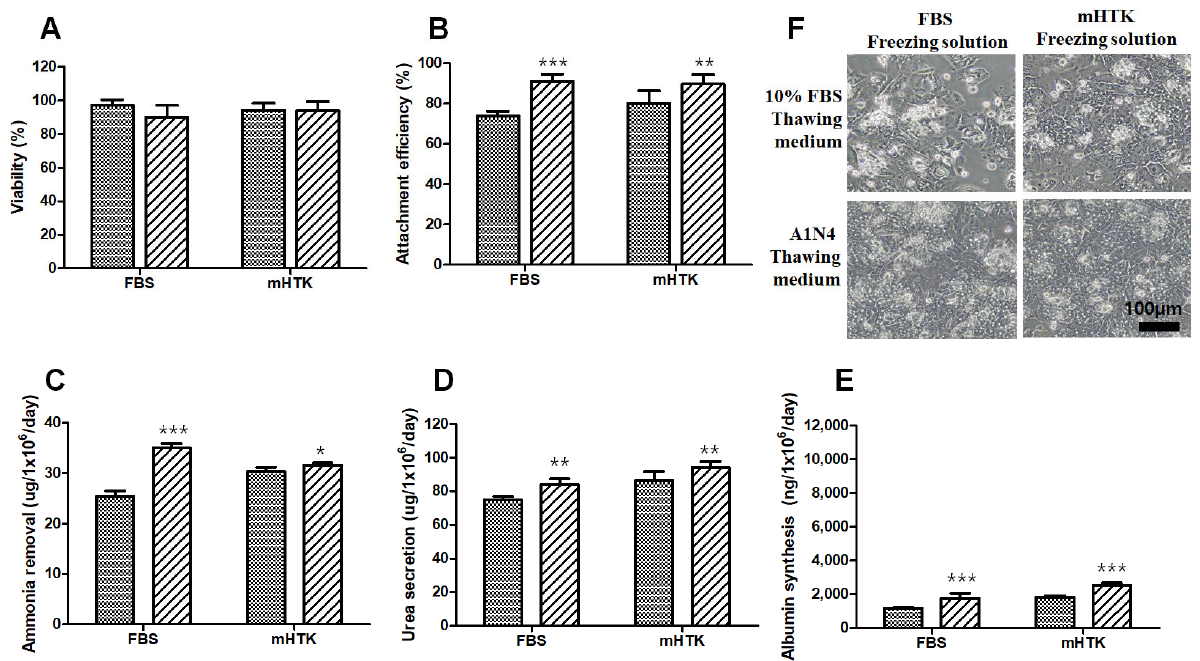
Figure 6. Effect of freezing and thawing solutions on porcine hepatocyte spheroids’ viability and liver-specific functions in post-thawing culture. Porcine hepatocyte spheroids were cryopreserved in two different freezing solutions supplemented with 15% DMSO and stored for 1 year in liquid nitrogen. Porcine hepatocyte spheroids were warmed rapidly using a water bath and washed twice in two different thawing solutions (a warm serum medium (10% FBS, ▩ ) or serum ‐ free medium )) and then resuspended in a warm complete medium and evaluated for ( A ) cell viability; ( B ) attachment efficiency using a (3-(4,5-dimethyl thiazol-2-yl)-2,5-diphenyltetrazolium bromide assay; ( C ) ammonia removal; ( D ) urea secretion; and ( E ) albumin synthesis after 24 h of culture. Representative images of ( F ) porcine hepatocyte spheroids showing their morphology after plating and maintenance in culture for 24 h. Cryopreserved hepatocytes using FBS then thawed using 10% FBS thawing medium (upper right) and A1N4 (lower left) or cryopreserved hepatocytes using mHTK and then thawed using 10% FBS thawing medium (upper right) and A1N4 (lower right).